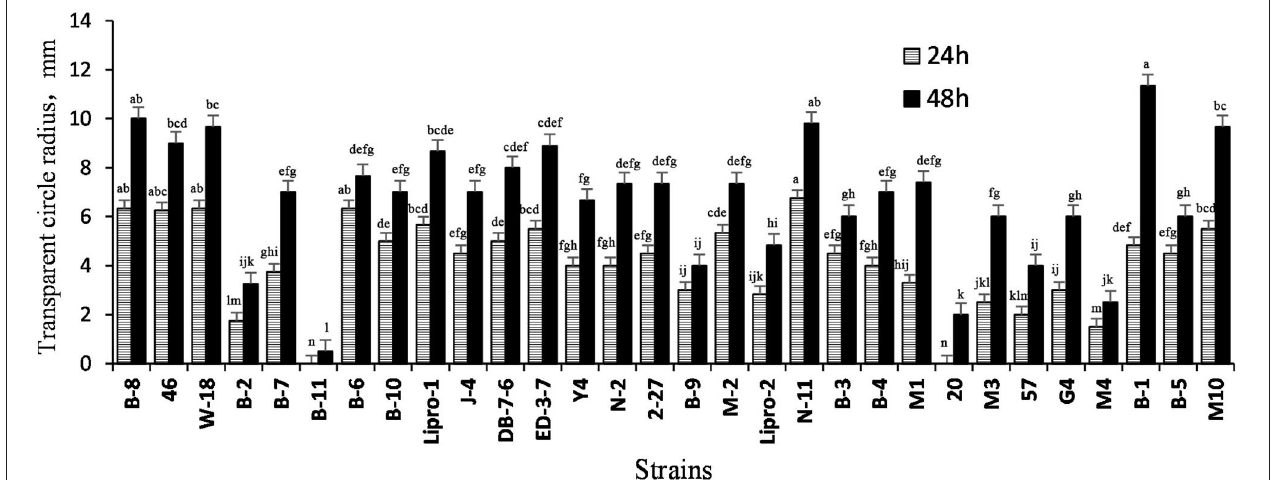
FIGURE 1 | The distance from the edge of the colony to the edge of the transparent circle on skimmed milk plate. Values are expressed as averages ± SD. Different letters indicate significant differences ( P < 0.05) among groups.